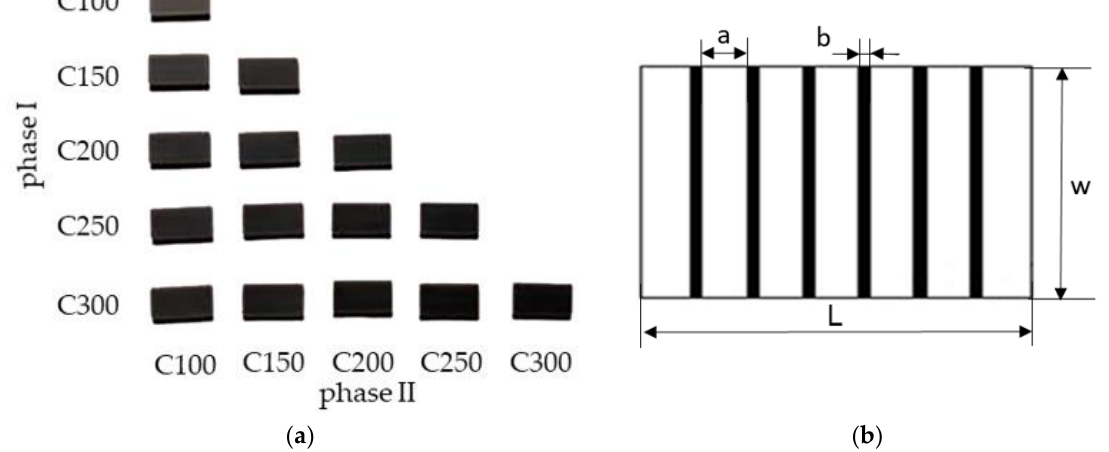
Figure 5. ( a ) Photographs of the 3D printed specimens for the tribological experiment; ( b ) the schematic diagram of soft and hard layered bionic materials.